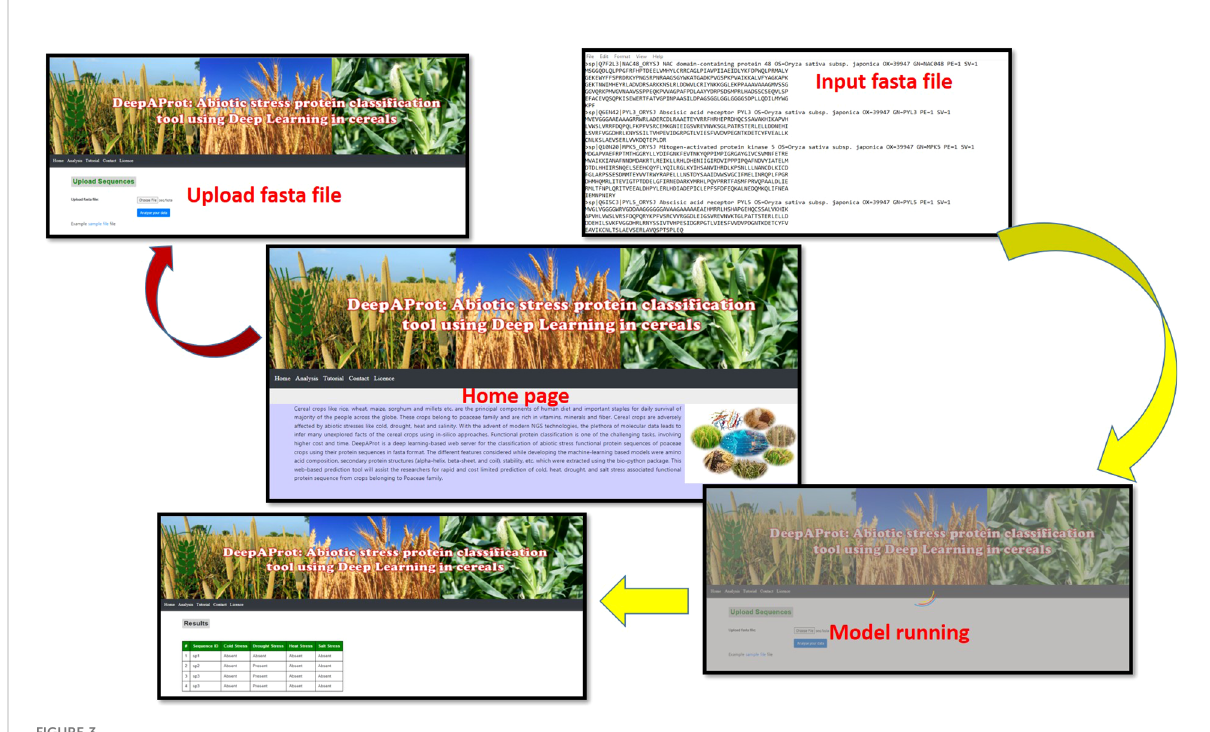
FIGURE 3 Interface for use of